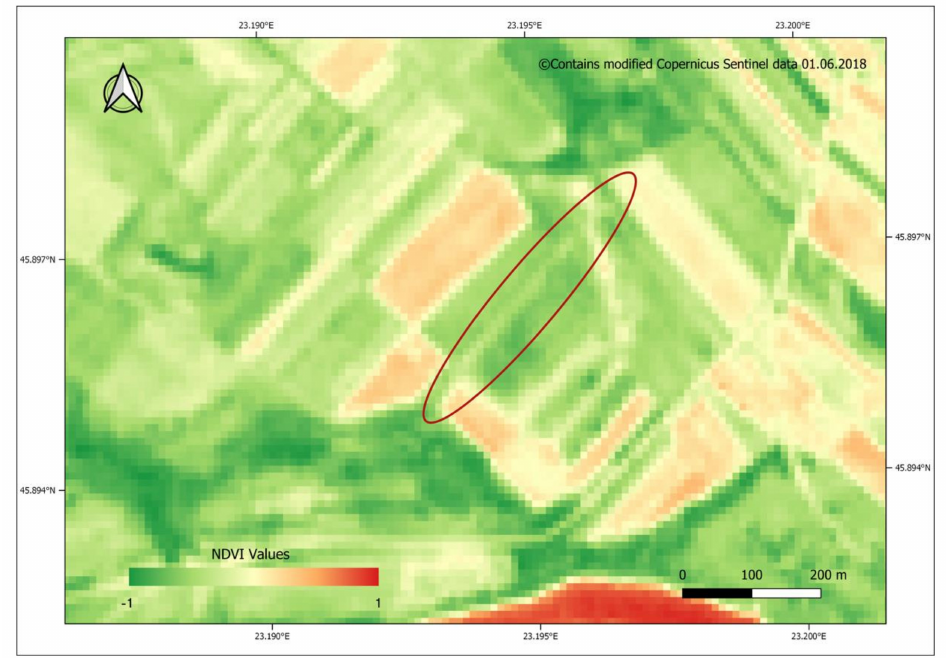
Figure 14. NDVI image output derived from Sentinel–2 imagery. The highlighted feature represents the underground Roman road that connected Germisara Roman Fort with Geoagiu–B ă